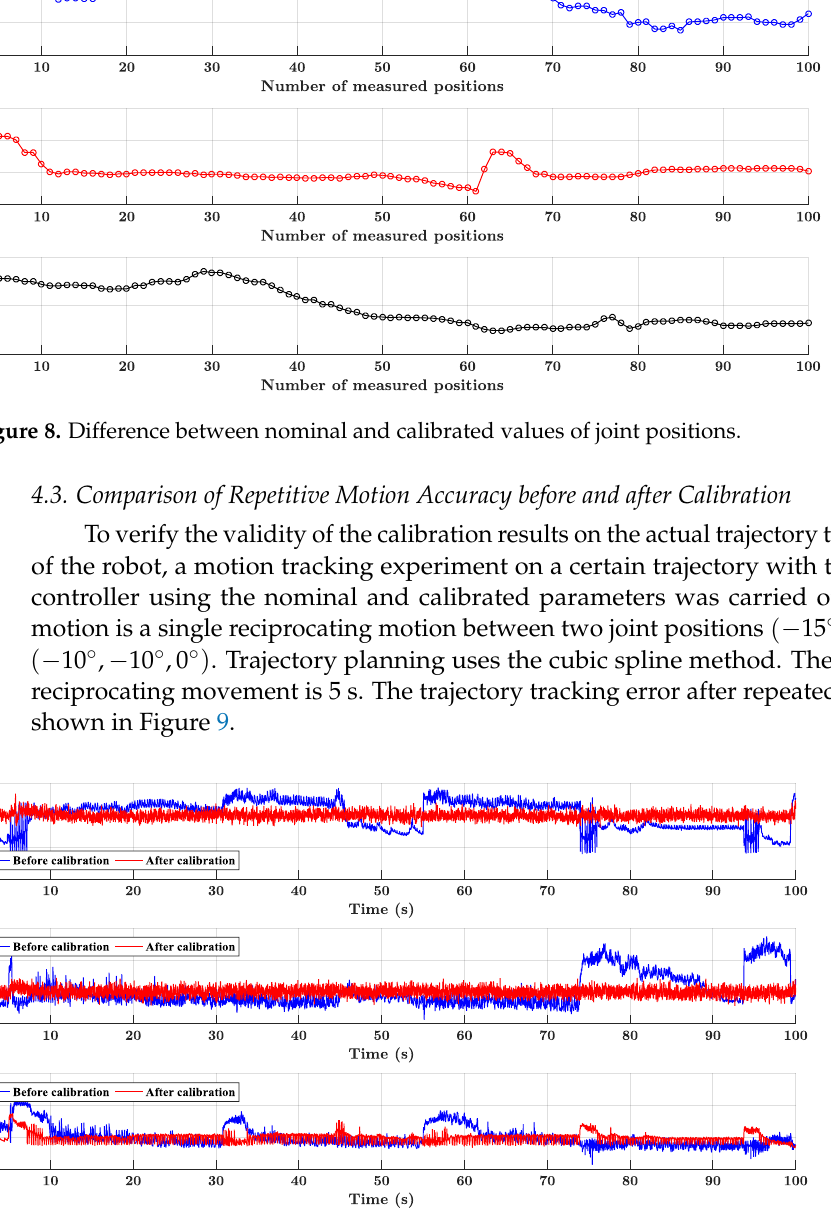
Figure 9. Trajectory tracking errors of the same controller using the nominal and calibration val- ues.